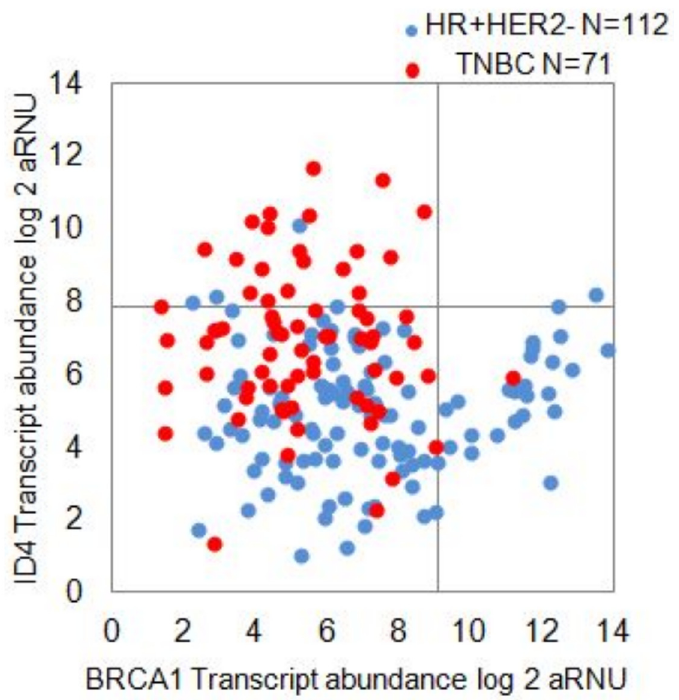
Fig 3. Relationship between BRCA1 and ID4. Relationship between BRCA1 and ID4.A four quadrant plot with “ cut-off ” lines for both transcripts that are at 1 SD above the mean value of all specimens. The upper right quadrant representing high ID4 and high BRCA1 is empty. The upper left quadrant of high ID4 and low BRCA1 is almost exclusively TNBCs while the lower right quadrant of high BRCA1 and low ID4 is exclusively luminal